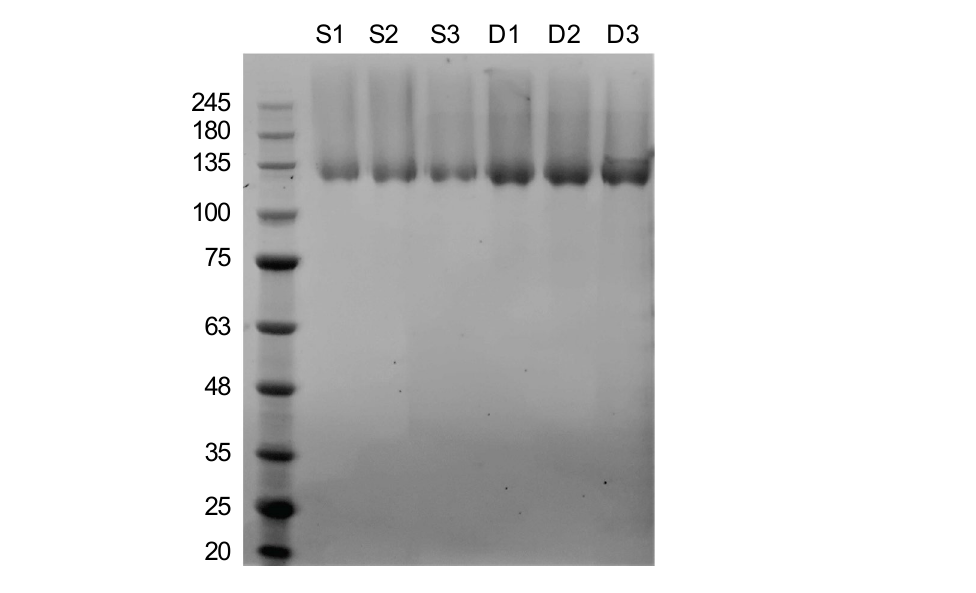
Figure 2. SDS-PAGE (4–20% Bis-Tris, MES) S1–S3: 20 µ L of Saccharolobus solfataricus P2 (SSO) sacculi using the extraction method with sonication (SEG). D1–D3: 20 µ L of SSO sacculi using the established extraction method with DNase I (DEG). The first lane corresponds to molecular mass standard with ladder units in kDa.